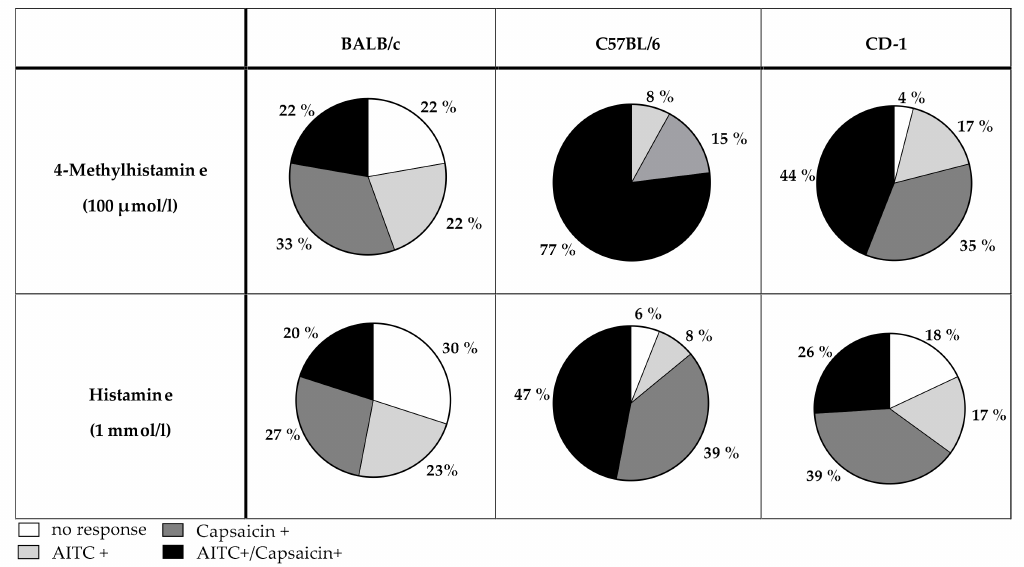
Figure 8. Differences in the reaction of 4-MH- and histamine-sensitive DRG neurons to TRPA1 (AITC, 1 µ mol/L) and TRPV1 (capsaicin, 1 µ mol/L) agonists in BALB/c, C57BL/6 and CD-1 mice. Neurons were classified into four groups: 1. Neurons not responding to any TRP channel agonist (=no response, white). 2. Neurons responding to capsaicin only (=capsaicin +, light grey). 3. Neurons responding to AITC only (=AITC+, dark grey). 4. Neurons responding to both AITC and capsaicin (=AITC+/capsaicin+, black). The pie charts show percentage values related to the total number of cells examined. Significantly more 4-MH neurons of C57BL/6 reacted to both AITC and capsaicin compared to BALB/c ( p < 0.04) and CD-1 ( p < 0.08). In alignment, more histamine-sensitive neurons of C57BL/6 reacted to both AITC and capsaicin compared to BALB/c ( p < 0.02) and CD-1 mice ( p < 0.002). Statistical significances were calculated with the Fisher’s exact test, and p values < 0.05 were considered statistically